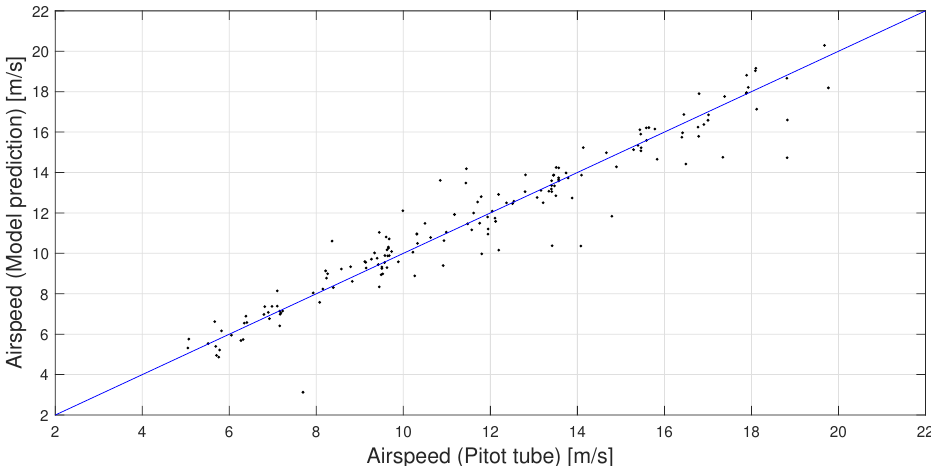
Figure 11. Comparison of the airspeed measured by the Pitot tube and the one predicted by the trained model for the validation